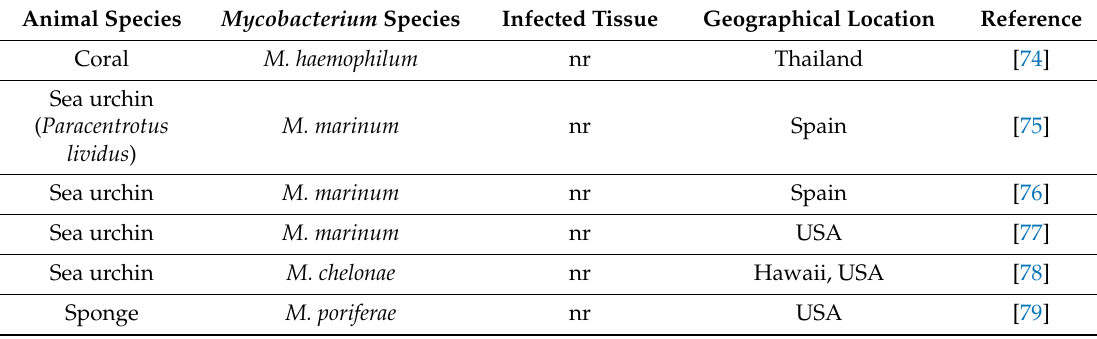
Table 3. Summary of echinoderm, cnidarian and sponge mycobacterioses, including animal species, Mycobacterium species, infected tissue, geographical location, and